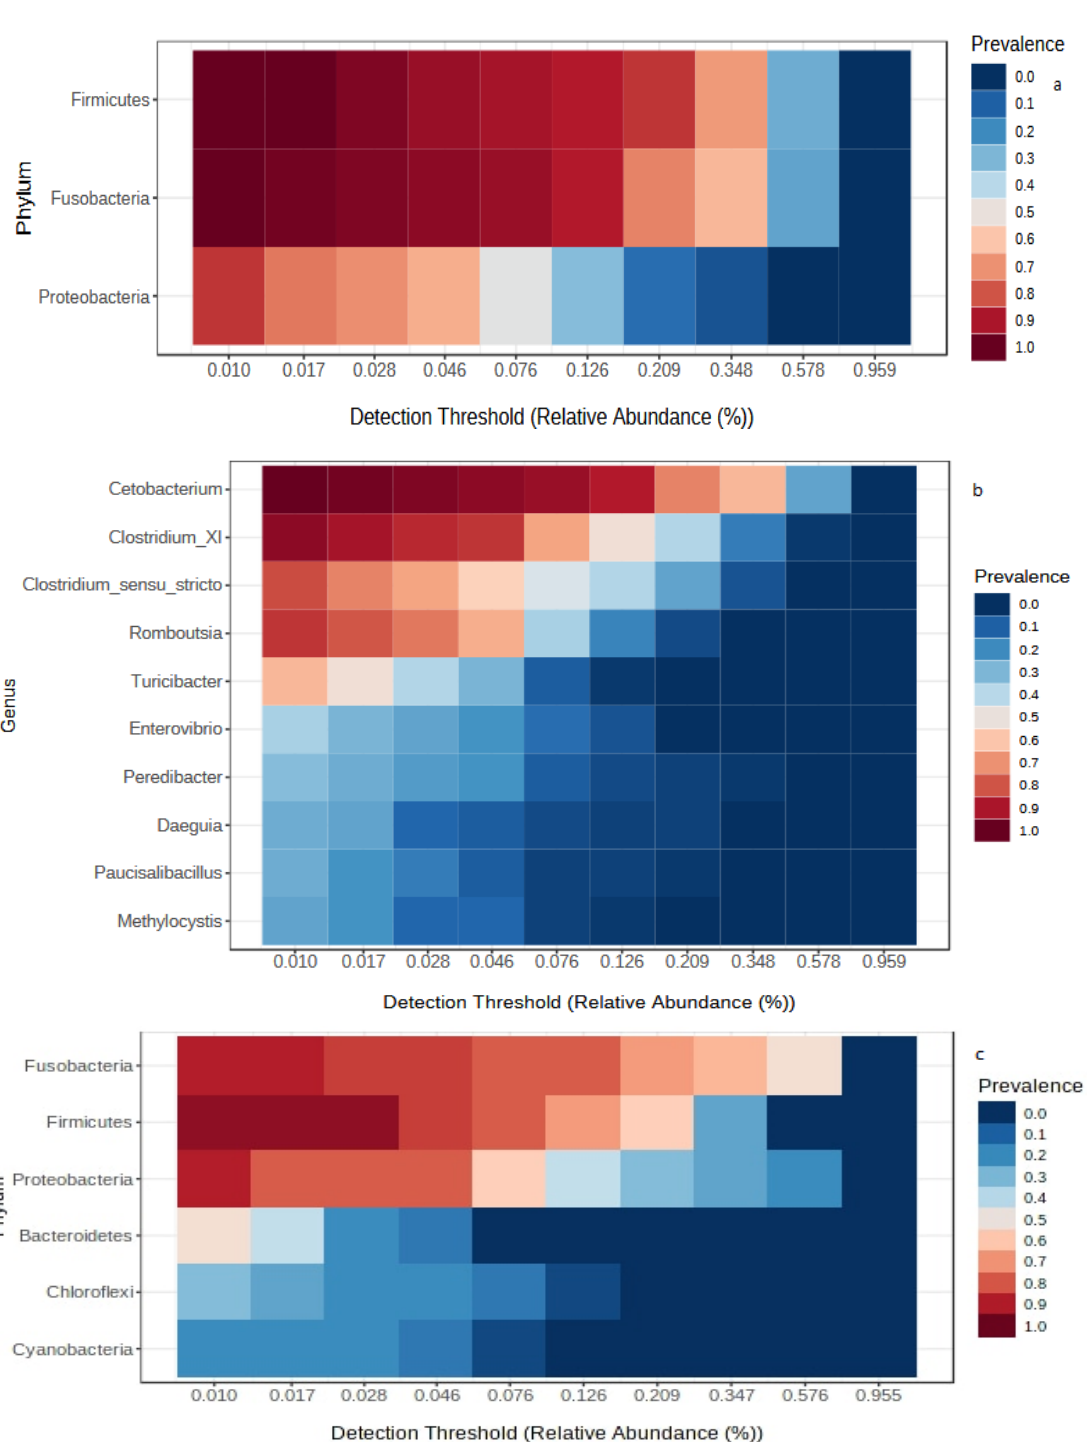
Figure 7. Heatmap showing the core microbiota. ( a ) Core phyla of all samples used in this study, ( b ) core genera of all samples, ( c ) core phyla from the comparison of the Lake Tana and aquaculture facility centre samples.